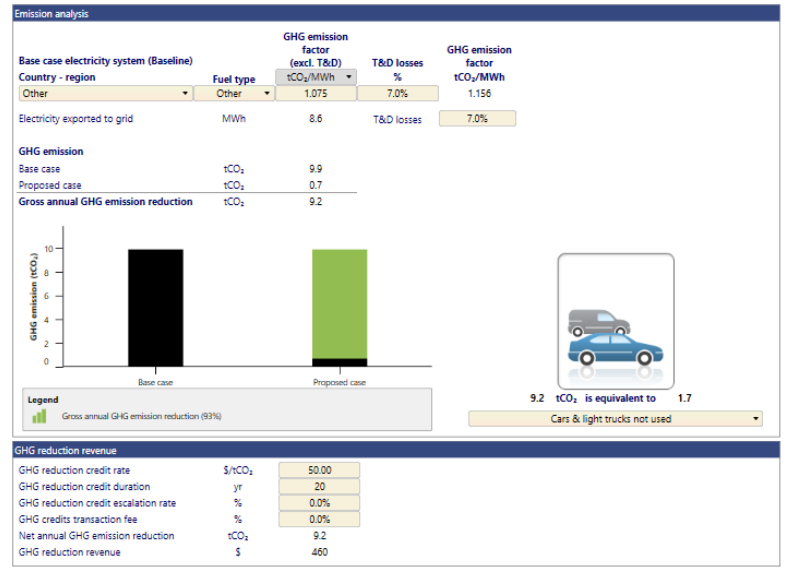
Figure 8. GHG emission reduction’s inputs in the case of the London, United Kingdom.